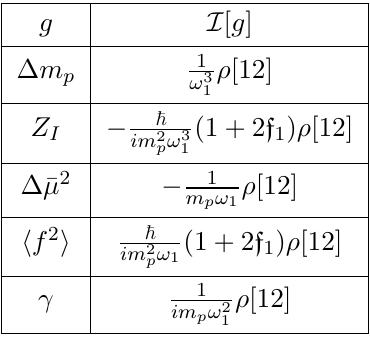
Table 2 . Sum rules for Quadratic Couplings (Thermal environment).